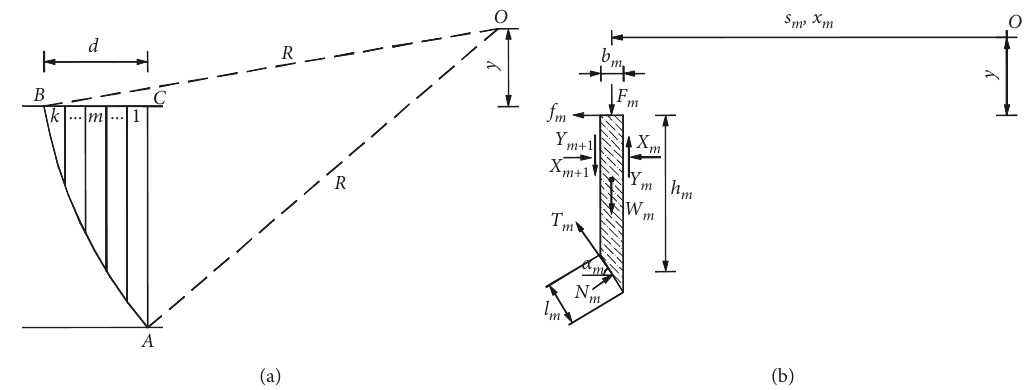
Figure 2: The Bishop mechanical model of sliding instability of coal